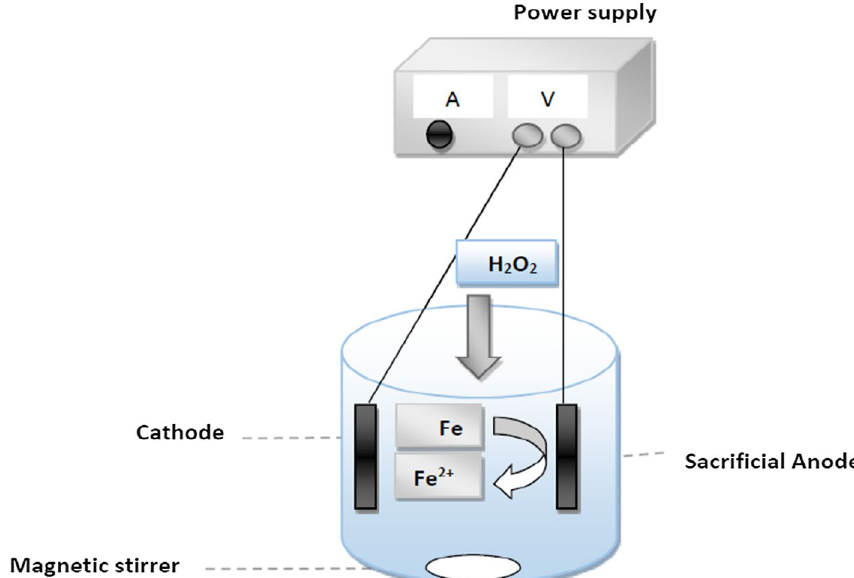
Fig. 2 The experimental